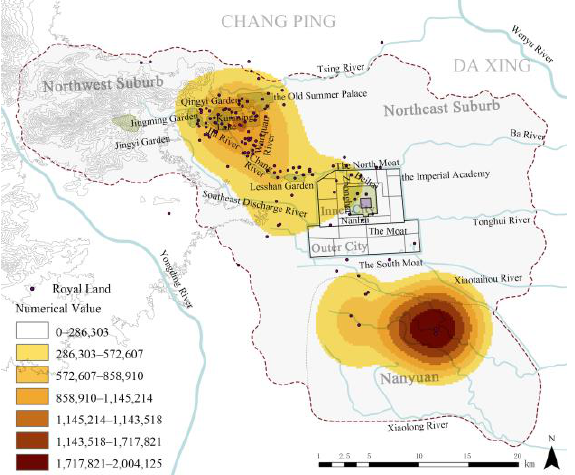
Figure 9. Spatial distribution and density analysis map of royal land.